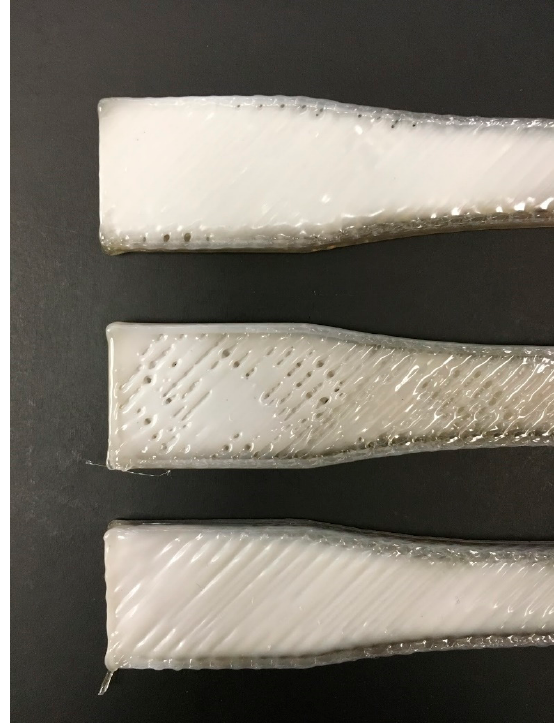
Figure 12. Close up of rPET water bottle tensile bars 3D printed with the same print settings. Inconsistent extrusion caused both under extrusion (top, middle) and over extrusion (bottom), with under extruded sections resulting in macro voids that decreased the UTS of the tensile bar.